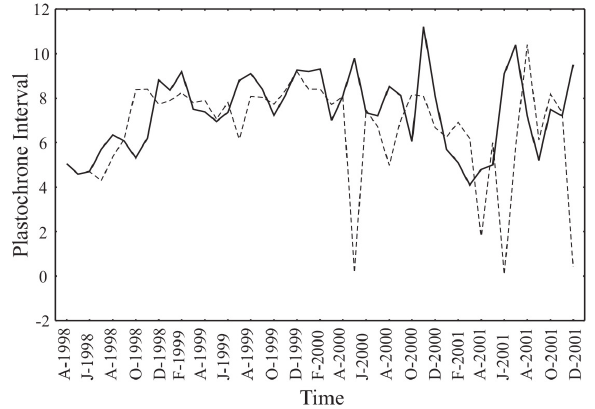
Fig . 4. – the continuous line shows plastochrone intervals deter- mined through time. the dashed line corresponds to equivalent values fitted through Equation (3) and the variable θ ( t ) was char- acterised by mEi values through time. the best fit was obtained for n =15 and produced a determination coefficient of R 2 =0.58. mEi index corresponds to a multivariate measure of the EnSo signal as expressed in the first component of six observed variables: sea level pressure, surface zonal and meridional wind components, sea sur- face temperature, surface air, temperature and cloudiness (Wolker and timlin, 1993). For P ( t ) standing for observed plastochrone interval values the fitted model is given by: P ( t ) = 8.3 + 3.2 θ ( t ) – 18.1 θ ( t ) 2 – 33.4 θ ( t ) 3 + 17.9 θ ( t ) 4 – 17.2 θ ( t ) 5 + 56 θ ( t ) 6 – 17.2 θ ( t ) 7 + 21.9 θ ( t ) 8 – 19.2 θ ( t ) 9 + 56.9 θ ( t ) 10 – 25.1 θ ( t ) i 11 – 65 θ ( t ) 12 + 21 θ ( t ) 13 + 17.2 θ ( t ) 14 – 5.9 θ ( t ) i